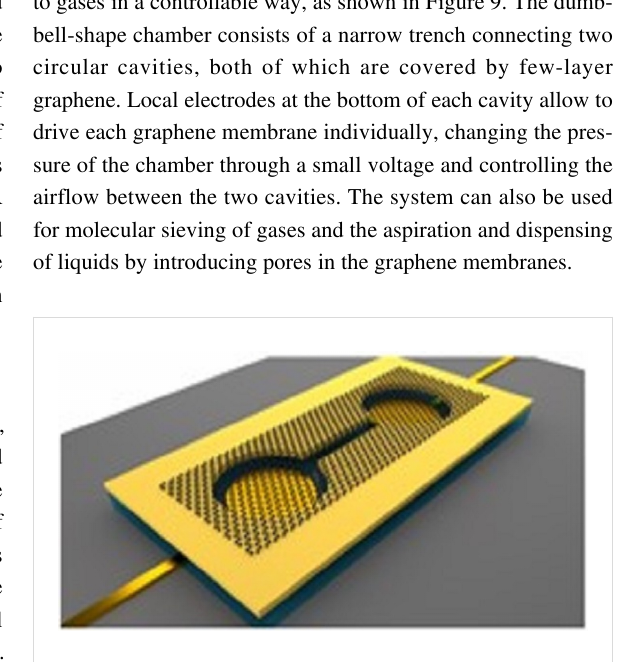
Figure 9: Schematic diagram of a GR pump. Figure 9 was repub- lished from [78] (D. Davidovikj et al., “Graphene gas pumps”, 2D